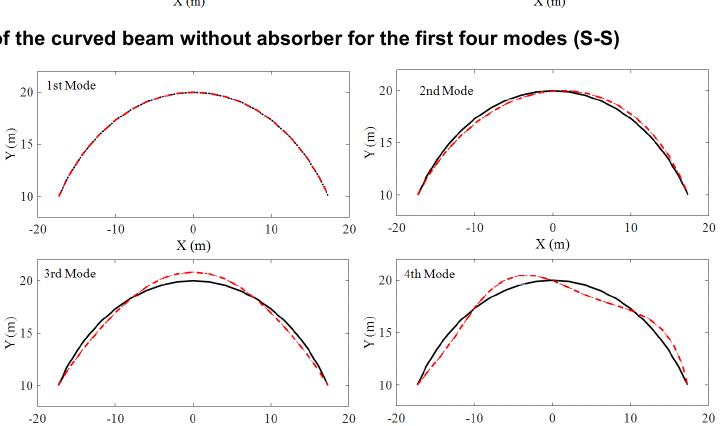
Figure 8. The mode shape of the curved beam without absorber for the first four modes (S-S)